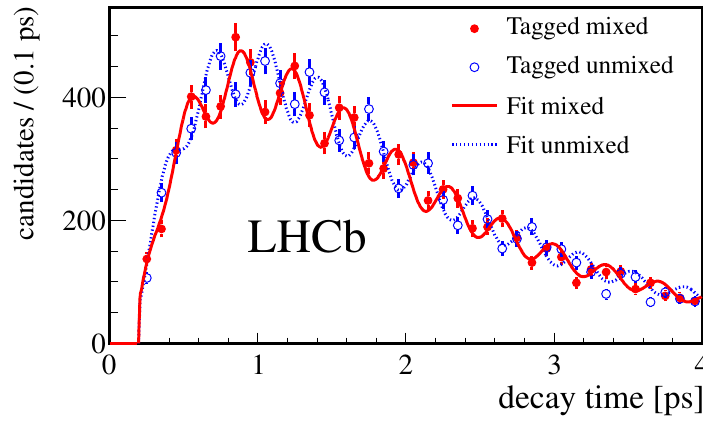
Figure 1 . Decay time distribution of (cid:13)avour-tagged B 0 detector in the B 0 ! D (cid:0) (cid:25) + decays s s